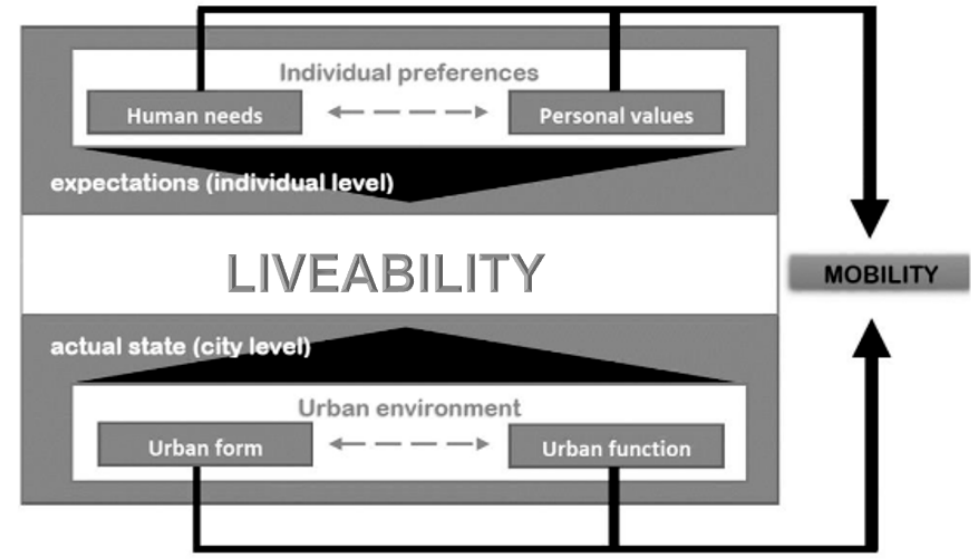
Figure 1. Conceptual framework for livability [40].